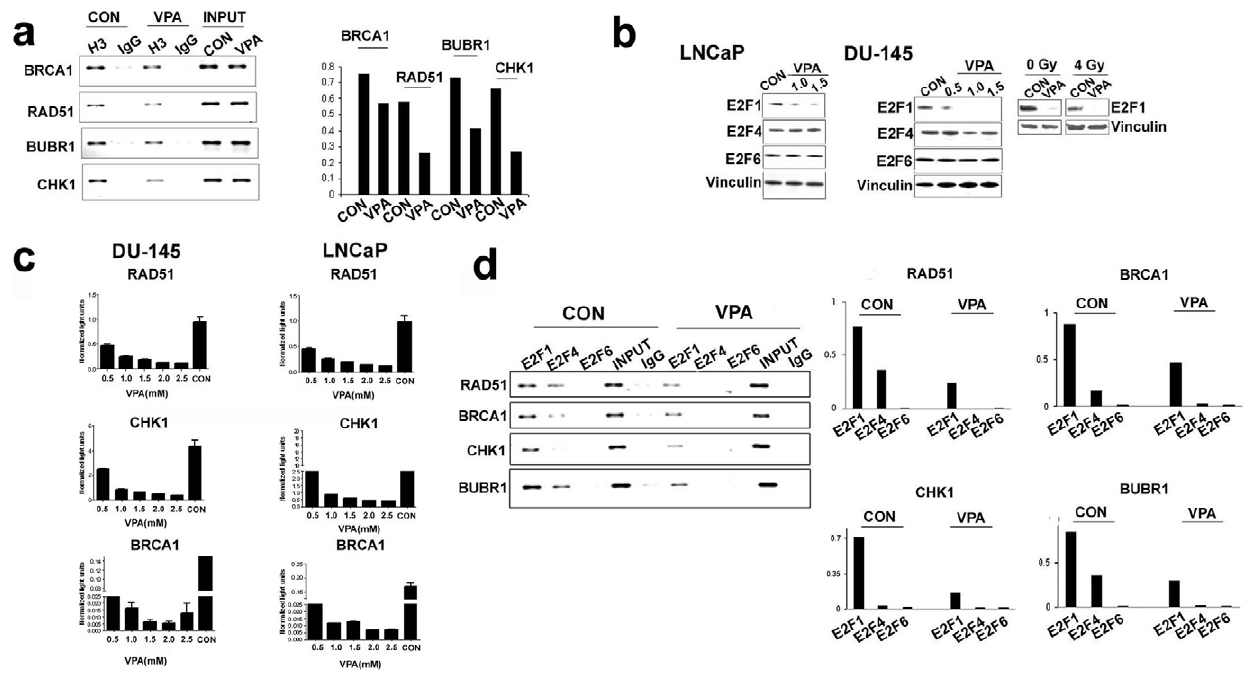
Figure 7. Downregulation of E2F1 mediates downregulation of DNA damage and response genes. a) ChIP analysis of VPA (1.5 mM for 48 h) treated DU-145 cells for acetylated histone H3 status in the promoters of repair genes. The bar diagram is a densitometry reading of the agarose gel shown normalized to inputs. b) Activator and repressor E2F protein levels in VPA (1.5 mM for 48 h) treated cells LNCaP and DU-145 cells.E2F levels remained downregulated upon VPA treatment even after irradiation with 4Gy radiation as shown in DU-145 cells, unirradiated (0Gy) cells served as a radiation control. c) Luciferase reporter assays in DU-145 and LNCaP cells, treated with varying concentrations of VPA, using proximal promoter regions, encompassing E2F binding regions of downregulated repair genes. d) ChIP analysis for E2F occupancy in the promoter regions of downregulated genes. ChIP was performed using antibodies against E2Fs (1, 4, and 6) in VPA (1.5 mM for 48 h) treated and control DU-145 cells. The bar diagram represents densitometric readings normalized to respective